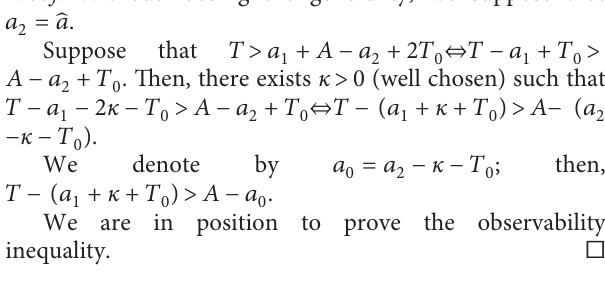
, a ) , and blue corresponds to the 0 1